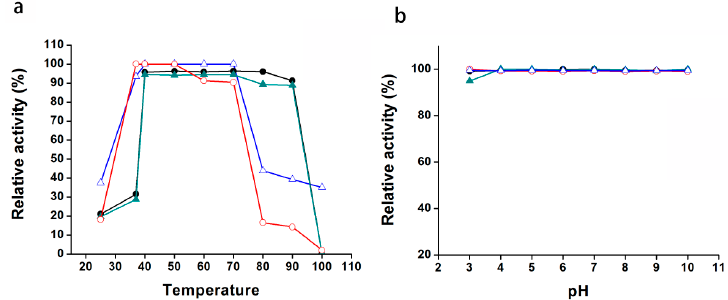
Figure 5. The temperature and pH stabilities of Pnserpin. ( a ) Effects of temperature on the activity of Pnserpin. The inhibitor was incubated at the indicated temperature for 15 min, and the residual inhibitory activities against CHT (red open circle), SUC (blue open triangle), elastase (black solid circle), and PRK (green solid triangle) were measured; ( b ) Effects of pH on the activity of Pnserpin. The inhibitor was incubated at the indicated pH for 24 h at room temperature, and the residual inhibitory activities against CHT (red open circle), SUC (blue open triangle), elastase (black solid circle), and PRK (green solid triangle) were measured.